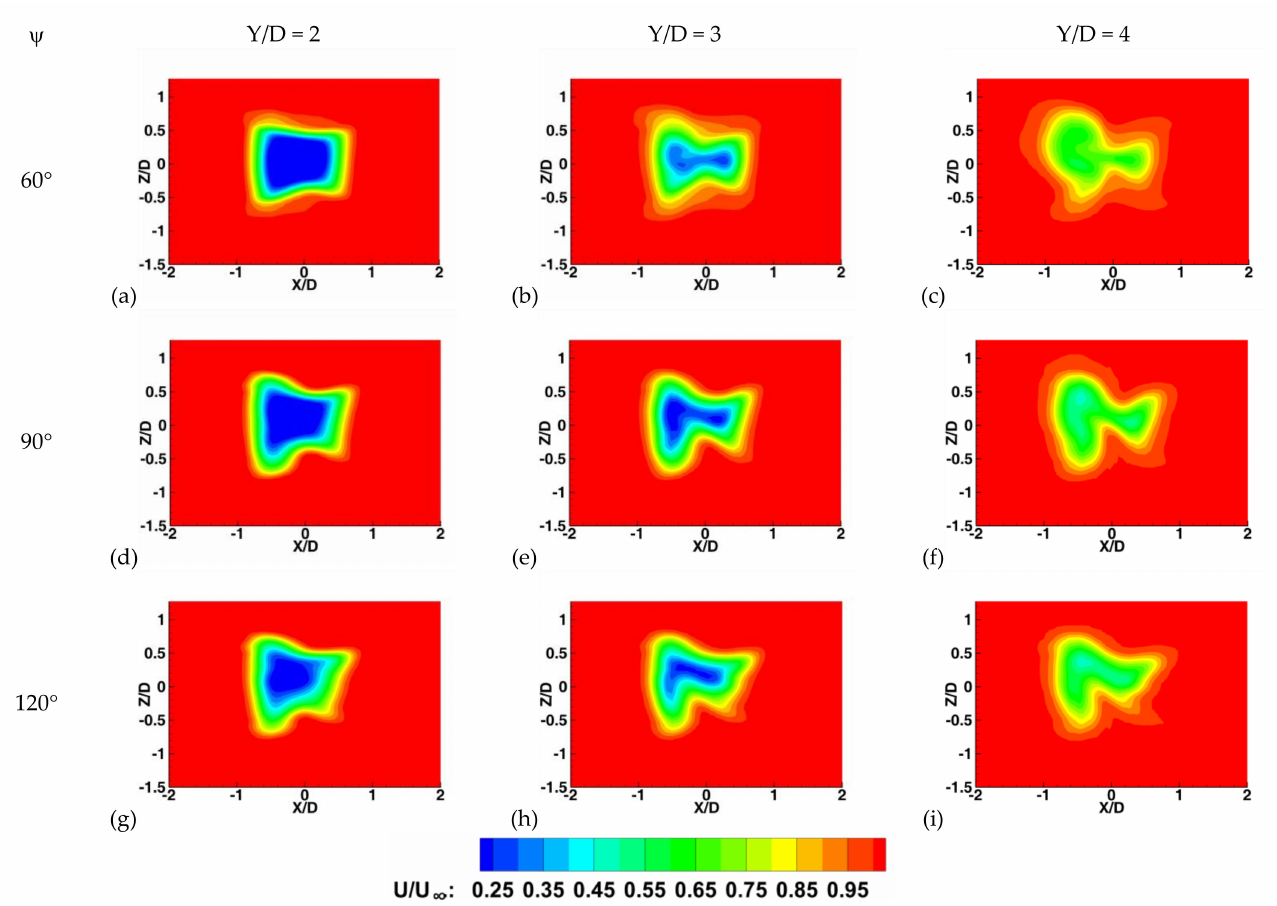
Figure 23. Wake structure of helical blade VAWT at Y/D of 2 ( a , d , g ), 3 ( b , e , h ), and 4 ( c , f , i ). For helical-bladed VAWT at TSR =